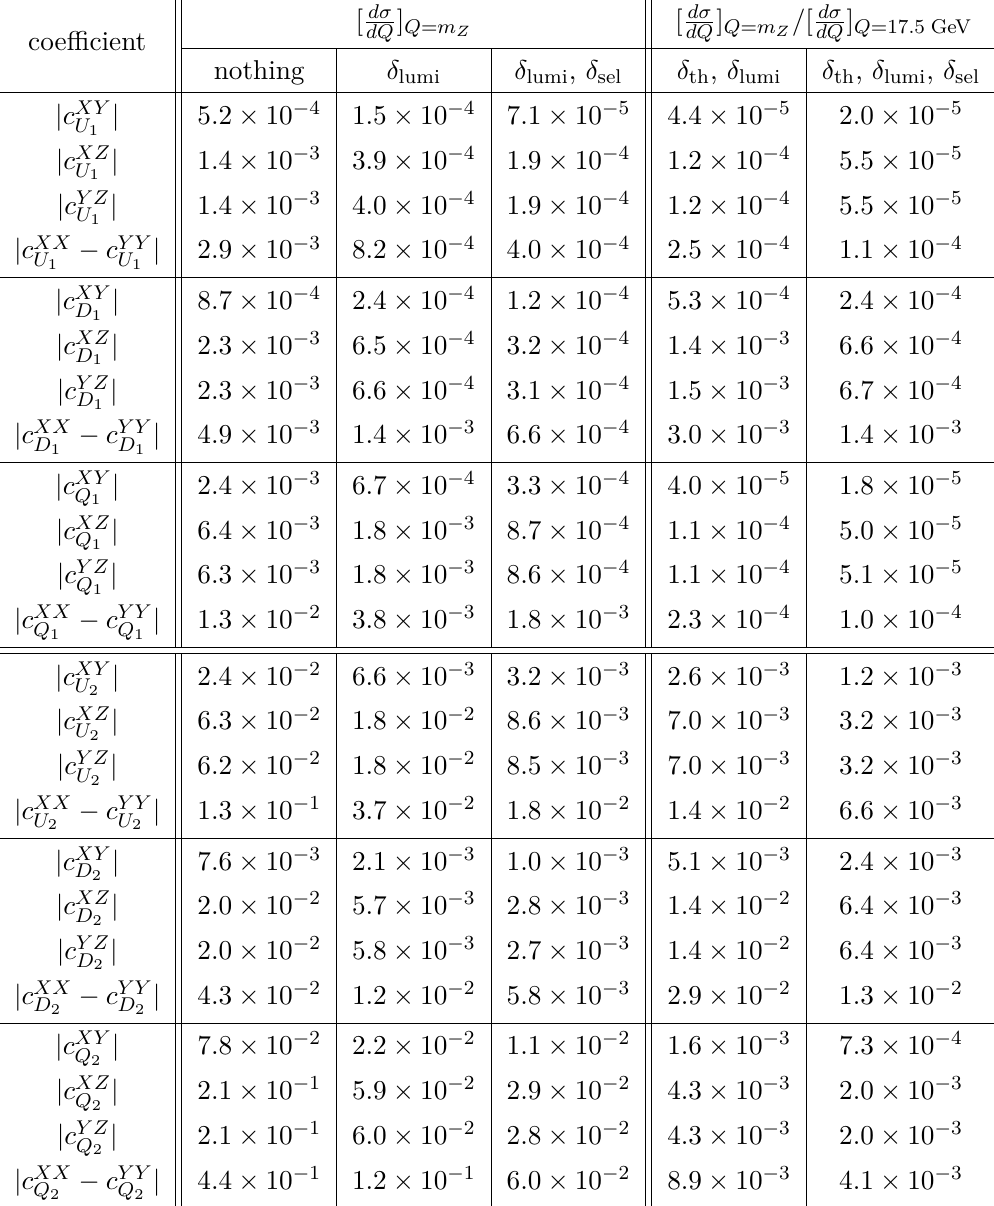
Table 4 . Expected best constraints on the time-dependent coefficients in the ( c U for Q = m Z and Q = 17 . 5 GeV . See the caption in table 2 for further